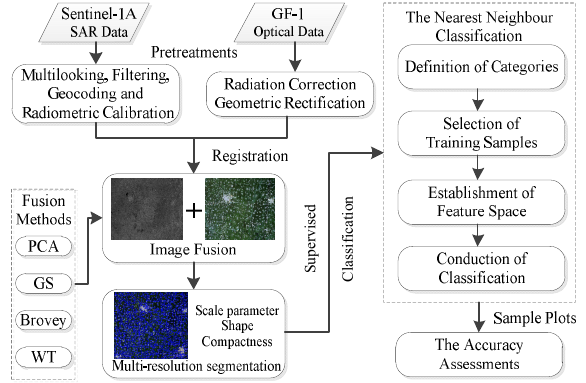
Figure 2. Flow chart of the nearest neighbour